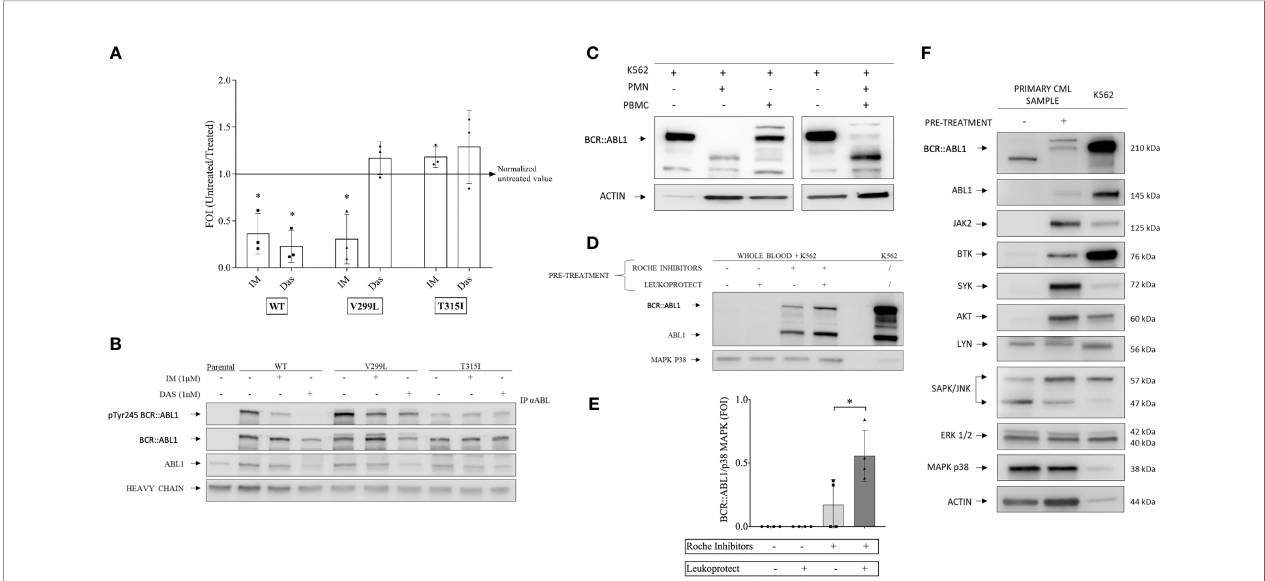
FIGURE 1 | Kinase assay optimization and setup of a protease protection protocol. (A) BCR-ABL1 and variants transfected into mouse-derived pro-B Ba/F3 cell lines were treated with 1 m M imatinib and 1 nM dasatinib for 12 h alongside an aliquot of each cell type and non-transfected Ba/F3 maintained without tyrosine kinase inhibitors as controls. Scatter plots represent three independent experiments in which the kinase activity measurements were normalized to a total BCR-ABL1 protein amount detected by Western blot analysis of immunoprecipitated samples. One-way ANOVA multiple comparison was applied for all cell lines with a p -value signi fi cance threshold of < 0.05 applied. (B) Examples of Western blot analysis of immunoprecipitated BCL-ABL1 and variants from the experiments shown in (A) . (C) Polymorphonuclear neutrophils (PMNs) and peripheral blood mononuclear cells were collected from healthy donor blood. Each cell population was spiked with BCR-ABL1-positive cell line (K562) at 10:1 ratio. The cell mixture was lysed using a non-denaturing lysis buffer, including protease inhibitors, as described in the Supplementary Information . Total protein was quanti fi ed via the Bradford assay, and Western blot analysis was performed, showing that the PMN fraction contained a degradative activity. (D) Healthy whole-blood samples combined with K562 (ratio 10:1) were pretreated with Roche cOmplete ™ ULTRA Tablets inhibitors alone, LeukoProtect alone, or the combination of both. K562 cell lysate was used as a reference. (E) Densitometry analysis of BCR-ABL1 protein detected by Western blot as shown in (D) . One-way ANOVA multiple comparison was applied, with a p -value signi fi cance threshold of < 0.05 (*) applied. (F) Combined Roche and LeukoProtect (R+L) pre-treatment protocol preserves several kinases from degradation. Western blot analysis of lysates from CP-CML pre-treated (+) or not (-) with R+L before lysis. The membrane was probed with the speci fi c antibodies indicated. K562 cell lysate is loaded as a reference. *p< 0.05.